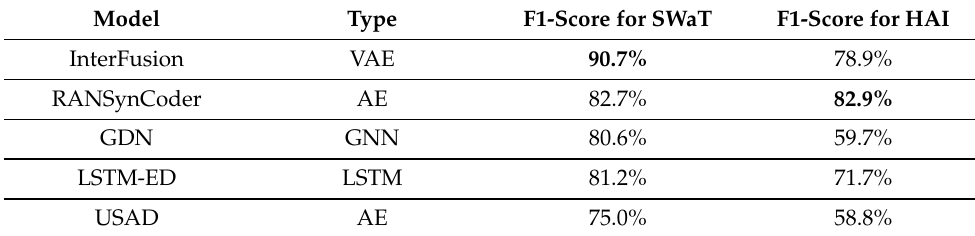
Table 10. Summary of five representative anomaly detection